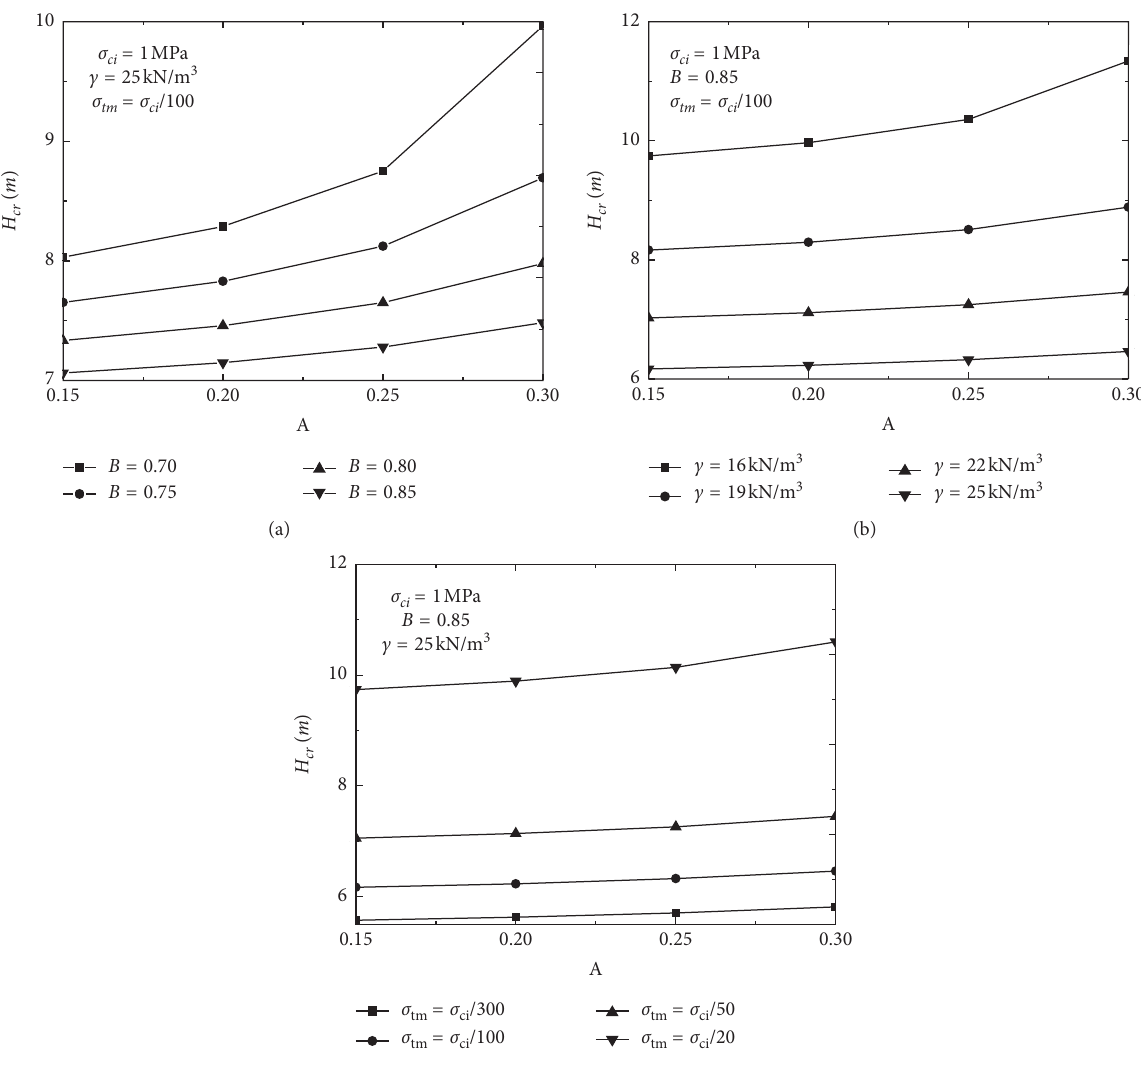
Figure 9: The influence of the different parameters on H values of c on H cr . (c) Influence of the different values of σ tm on H cr .